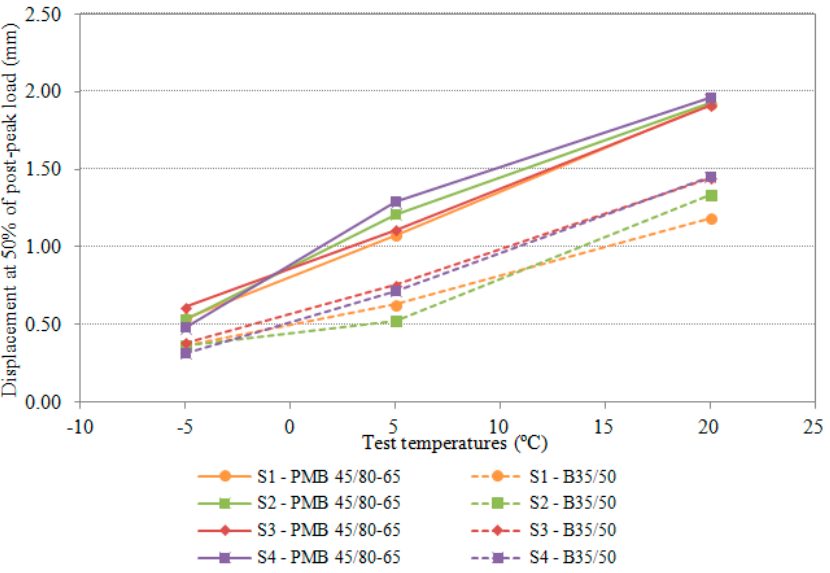
Figure 11. Displacement at 50% of post-peak load versus temperature.